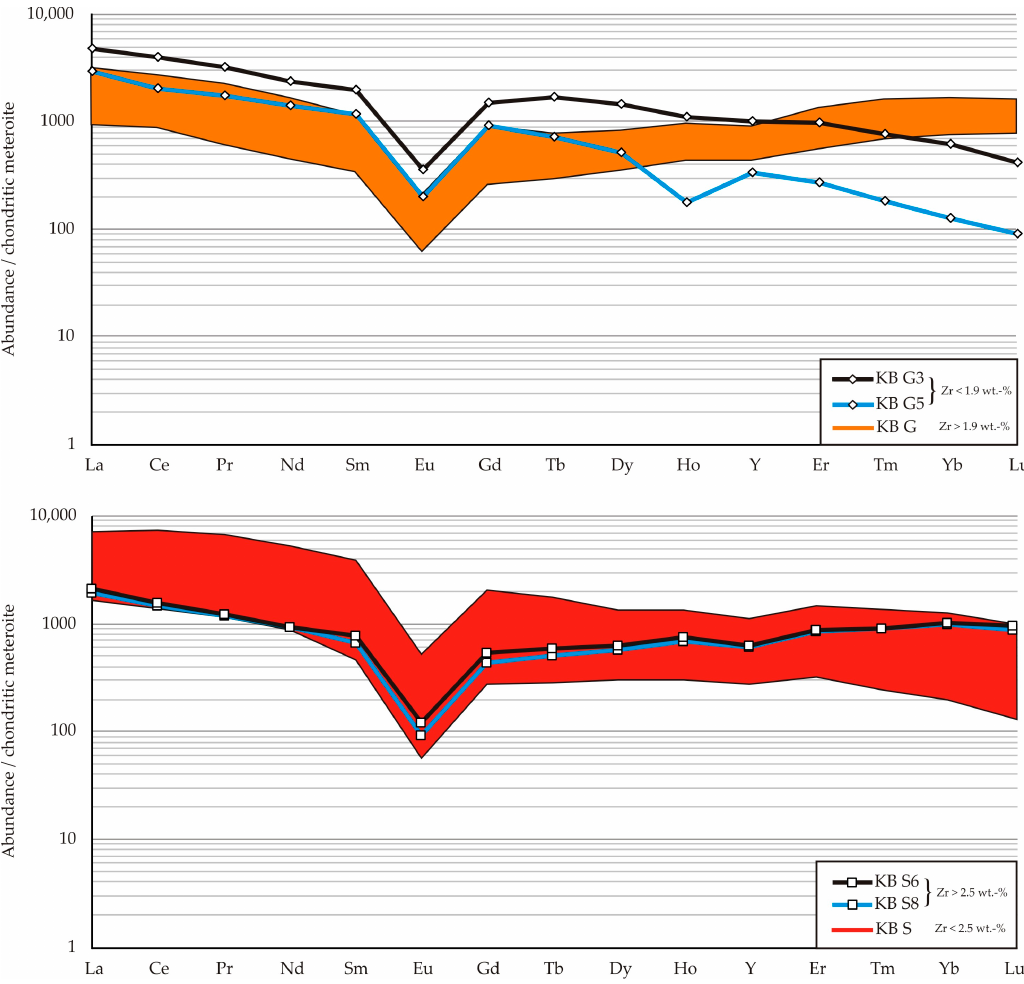
Figure 7. REE pattern for KB G ( upper ) and KB S ( lower ). Coloured range represents maximum and minimum values of individual sample patterns (orange and red) of parallel evolution for high content of Zr in KB G and low Zr content in KB S. The samples KB G3 and G5 were identified as having the lowest enrichment of Zr in the KB G samples and showed a decreasing tendency within the HREE. The same behaviour is shown for the KB S dataset where, in contrast, the samples KB S6 and S8 contain significantly higher amounts of Zr than the other samples (red range) representing the increasing tendency of the HREE. REE concentrations were normalized against chondritic composition according to [24].